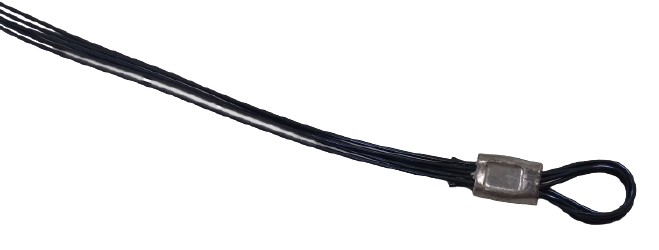
Figure 6. Crimping method for SMA wire